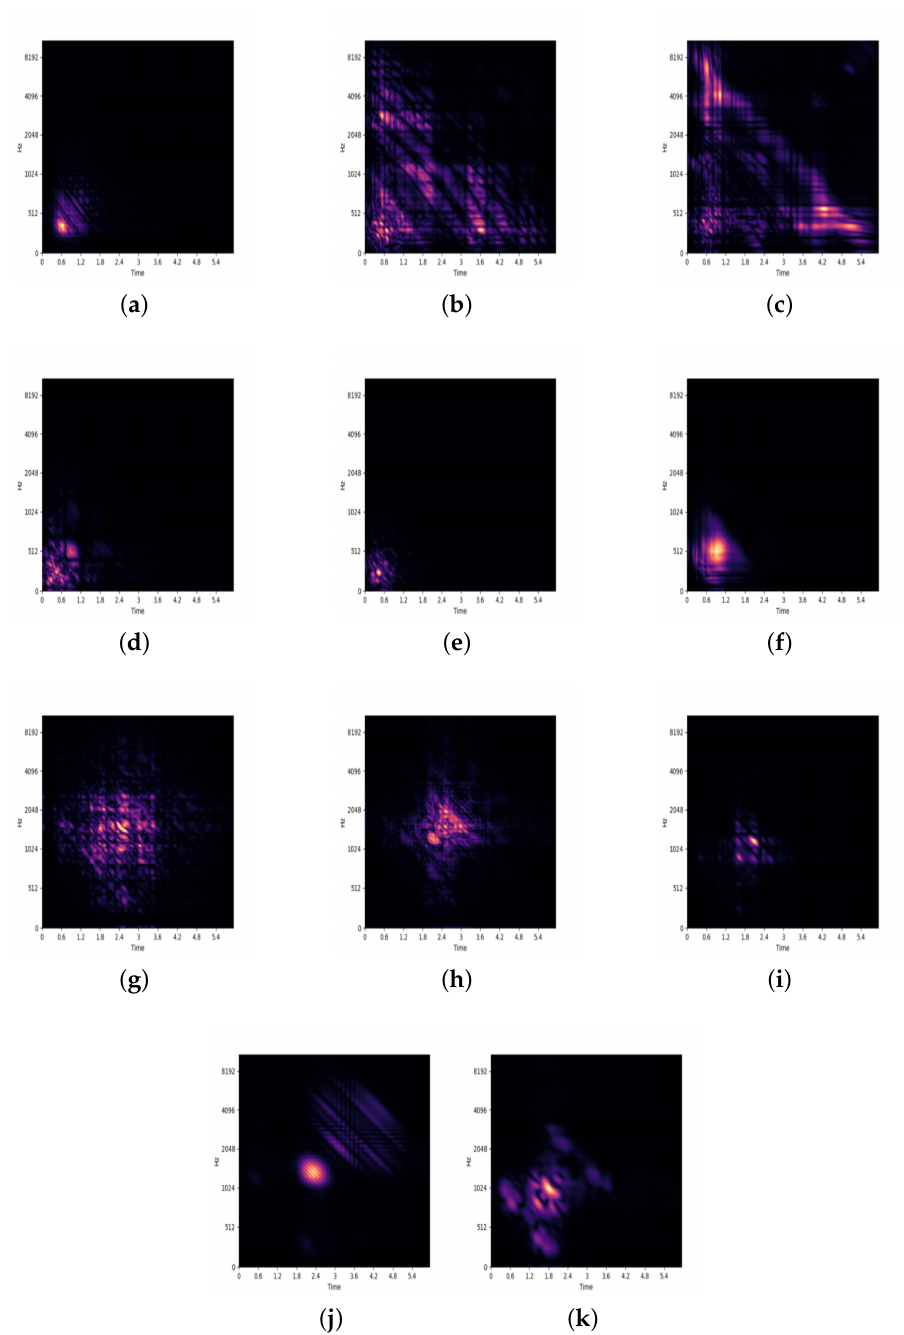
Figure 2. Generated bispectrum illustrations for every category of the lung and heart sound